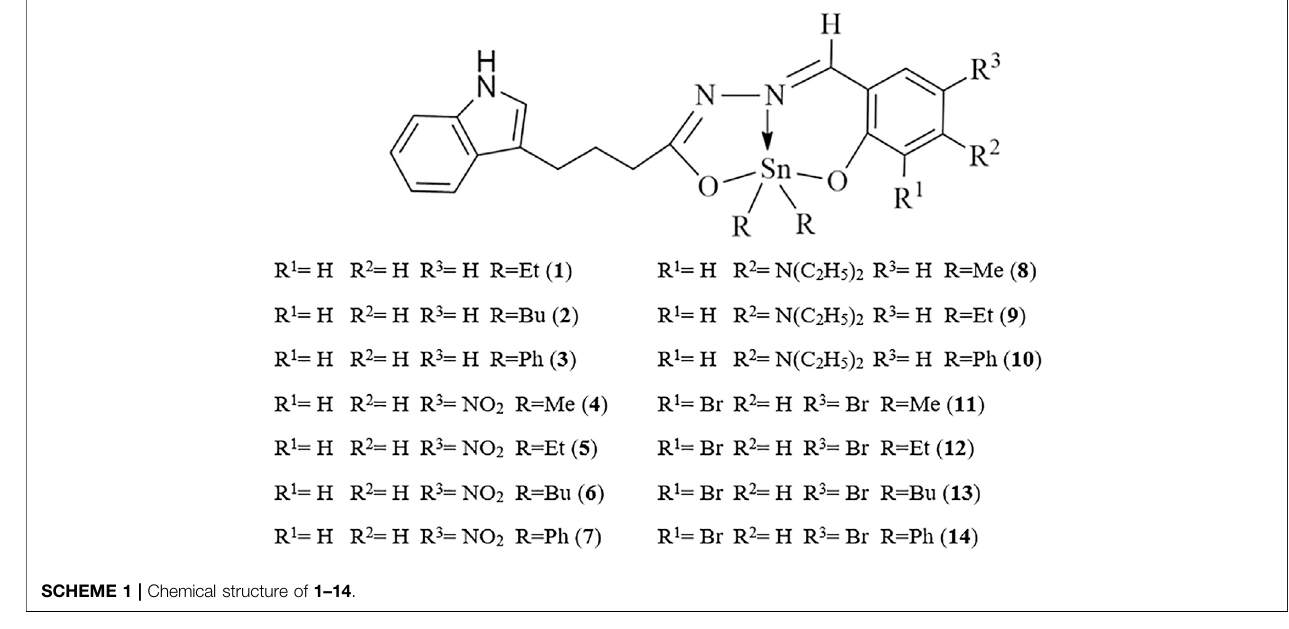
SCHEME 1 | Chemical structure of 1 – 14 .